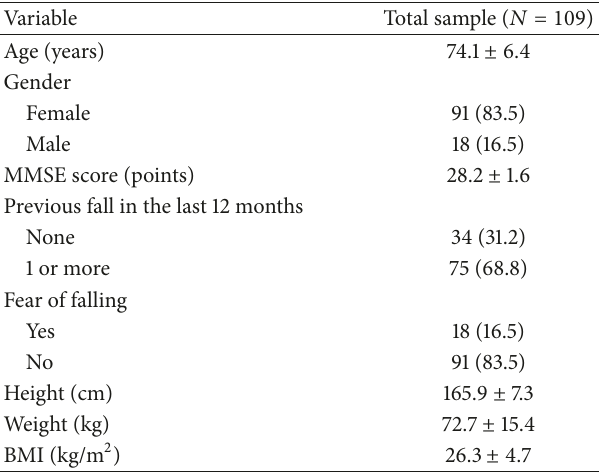
Table 2: Participant characteristics at